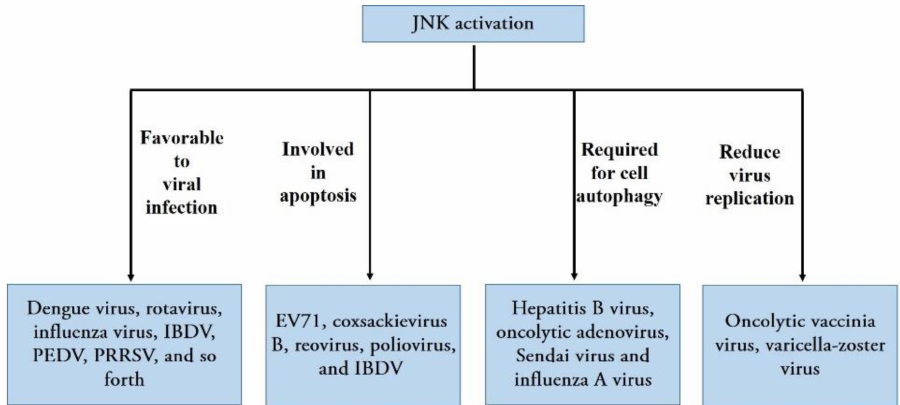
Figure 3. The different roles of JNK activation in regulating various viral infections; these include facilitating or reducing virus replication for different types of viruses and triggering apoptosis or autophagy during each virus